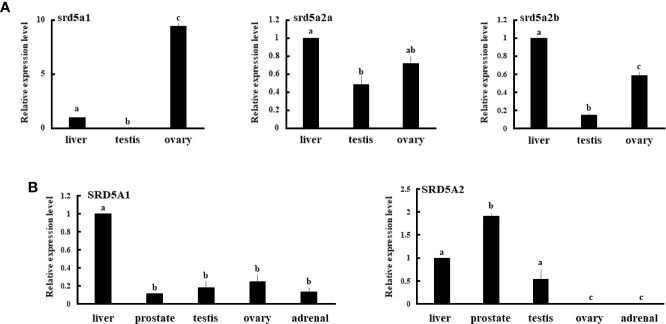
Expression of eel srd5a genes (A) and human SRD5A genes (B) in various tissues. mRNA expression of each gene in each tissue was analyzed by qPCR and normalized to ef-1 (A) or β-actin (B) expression. Data represent the mean ± SEM of at least three independent samples. Values marked by different letters are significantly different (P< 0.05).